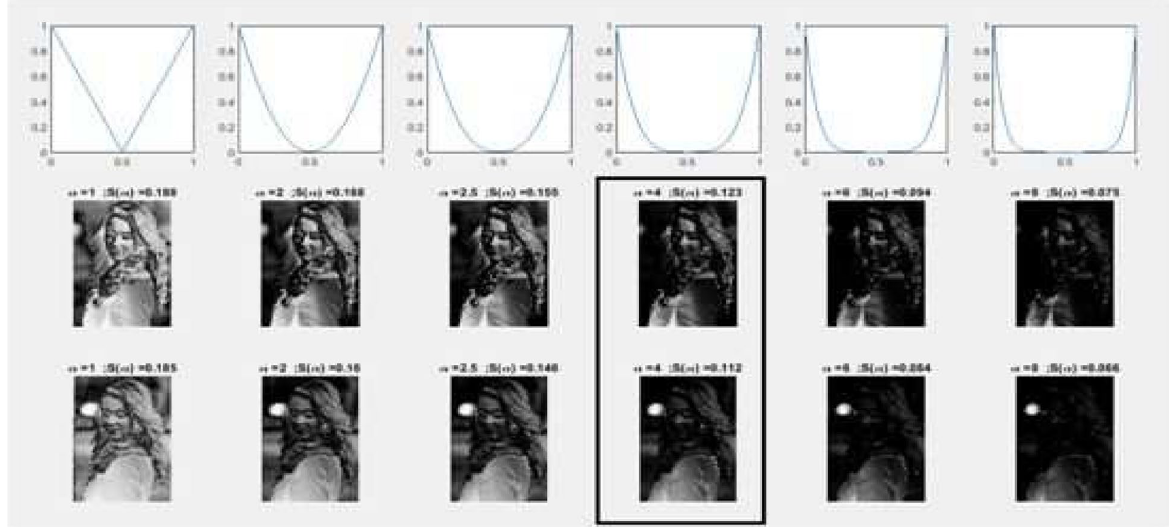
Fig. 10 Impact of changes in the exponential parameter α on both the versions from the TWIN-image set [28]. As the exponent increases, the self-shadows become much more discernible for the version where the lighting is normal. Beyond a certain point the ratio images corresponding to both the normal version and the diffused version become